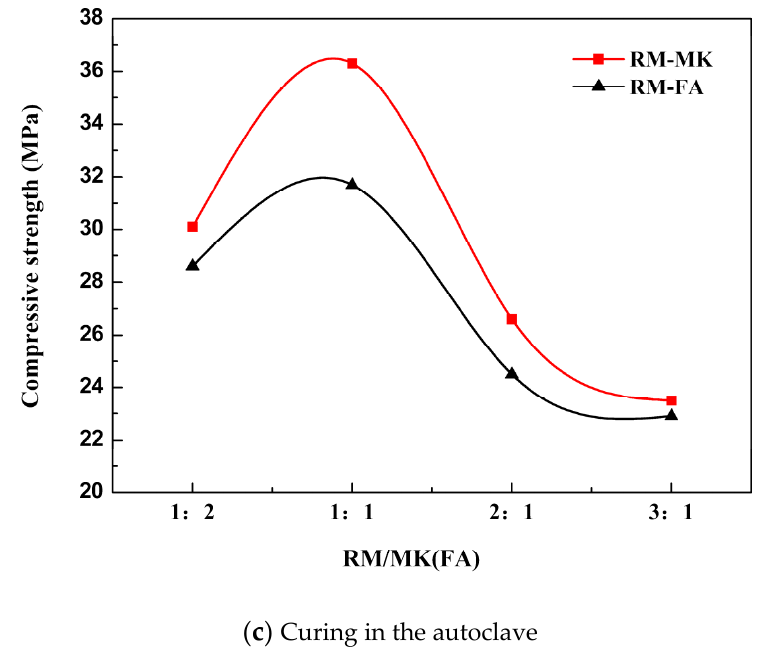
Figure 3. Variation in geopolymer compressive strength with red mud content.